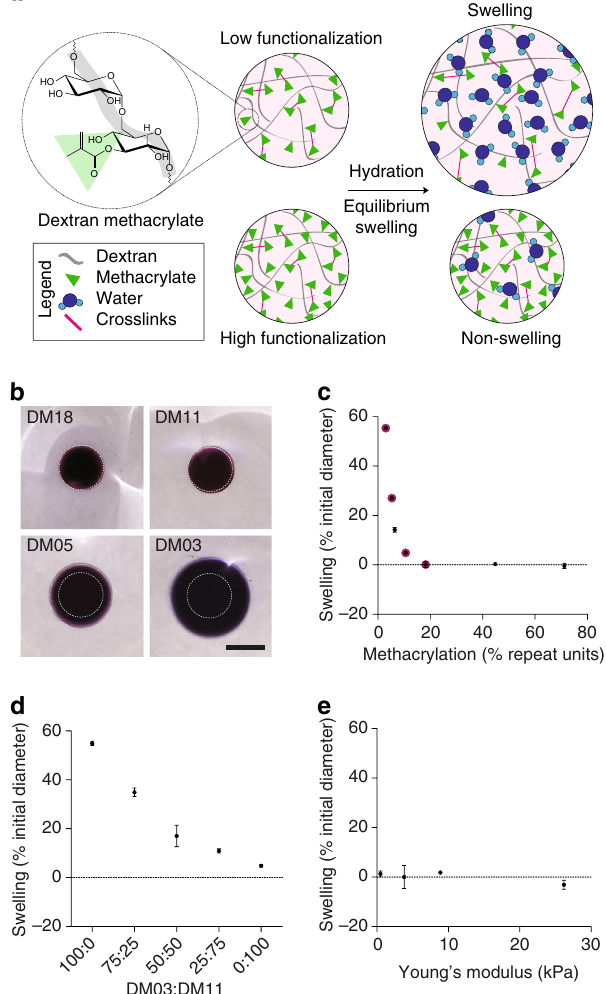
Fig. 1 Design of a class of hydrogels with controlled swelling properties. a Schematic representation of DexMA hydrogels with controlled swelling properties via addition of hydrophobic methacrylates. b UV-crosslinked DexMA hydrogels with different degrees of methacrylation (label indicates % methacrylation), corresponding to the magneta -labelled data points in c after equilibrium swelling. Initial dimensions immediately following crosslinking are outlined by dotted lines ( scale bar , 500 μ m). c Swelling (% change in gel diameter relative to initial diameter before equilibrium hydration) as a function of dextran backbone methacrylation. d Swelling of UV-crosslinked hydrogels made of DexMA with 3 and 11% methacrylation mixed at various ratios. e Swelling as a function of the mechanical properties (Young ’ s modulus in kPa) of the gels. All data is presented as a mean ±